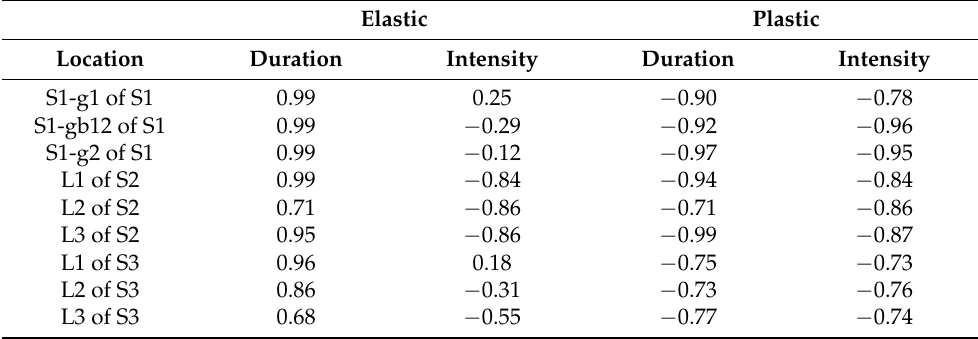
Table 3. The correlation coefficient between MBN transient eigenvalues ( T σ and INT σ ) and stress (or strain) in the elastic and plastic ranges.